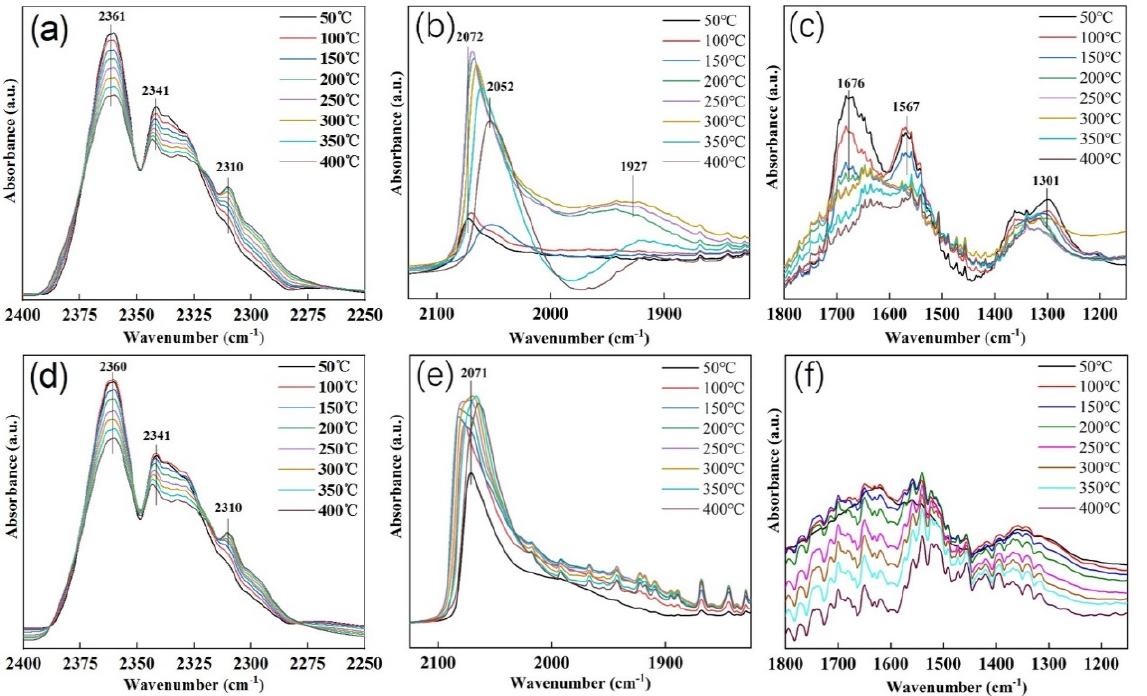
Figure 6. In-suit DRIFT spectra of species derived from H 2 and CO 2 co-adsorption on Pt/SrTiO 3 catalyst ( a – c ) and Pt/SrTiO 3 -L catalyst ( d – f ).